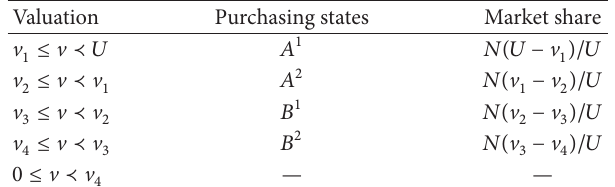
Table 1: Consumers’ preferences and the market shares in terms of